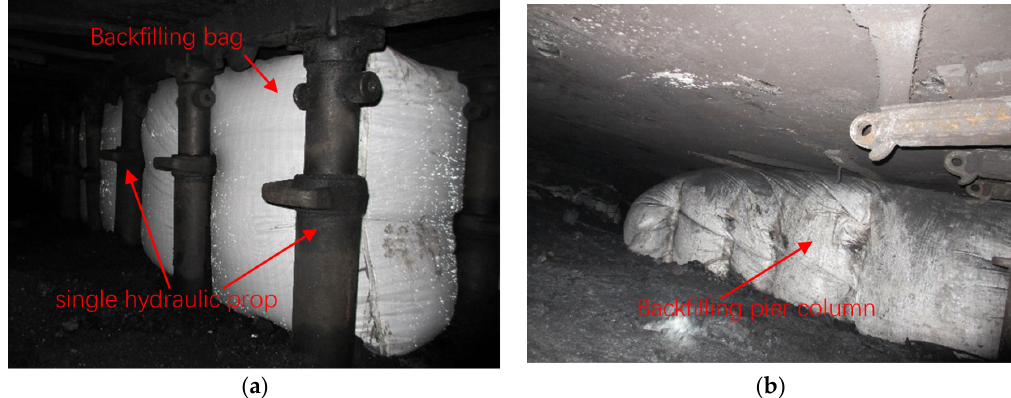
Figure 2. Pier ‐ column backfilling in the goaf: ( a ) before backfilling solidification; ( b ) after backfilling solidification.